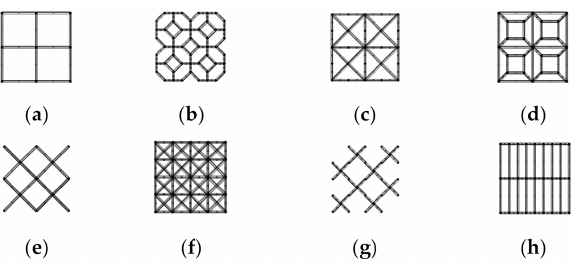
Figure 2. Unit cell lattice model: ( a ) grid; ( b ) vintiles; ( c ) star; ( d ) tesseract; ( e ) X; ( f ) diamond; ( g ) octet; ( h )